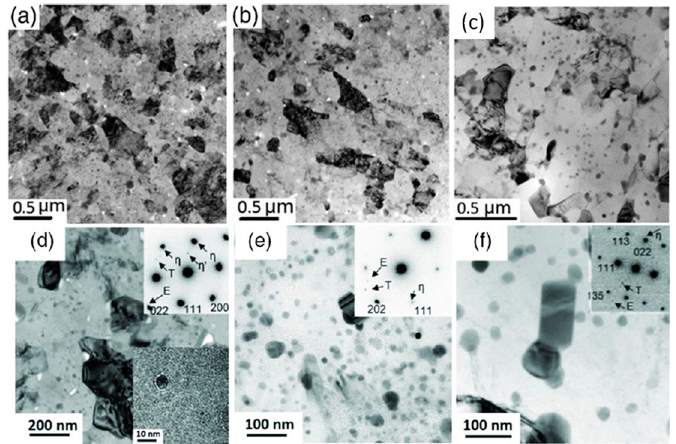
Figure 23. TEM images of annealing at different temperatures after 8 passes of ECAP [135]: ( a , d ) 393 K; ( b , e ) 423 K; ( c , f ) 473 K. Reproduced with permission from John Wiley & Sons, Inc.